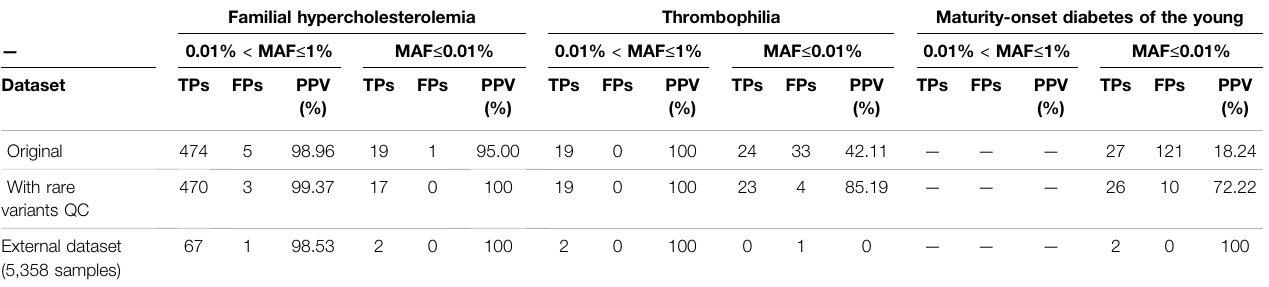
TABLE 1 | Performance of the TWB 2.0 in detecting rare pathogenic variants for familial hypercholesterolemia, thrombophilia, and maturity onset diabetes of the young in data with the original quality-control process, with rare variants quality-control procedure, and experimental veri fi cation. Familial hypercholesterolemia Thrombophilia Maturity-onset diabetes of the